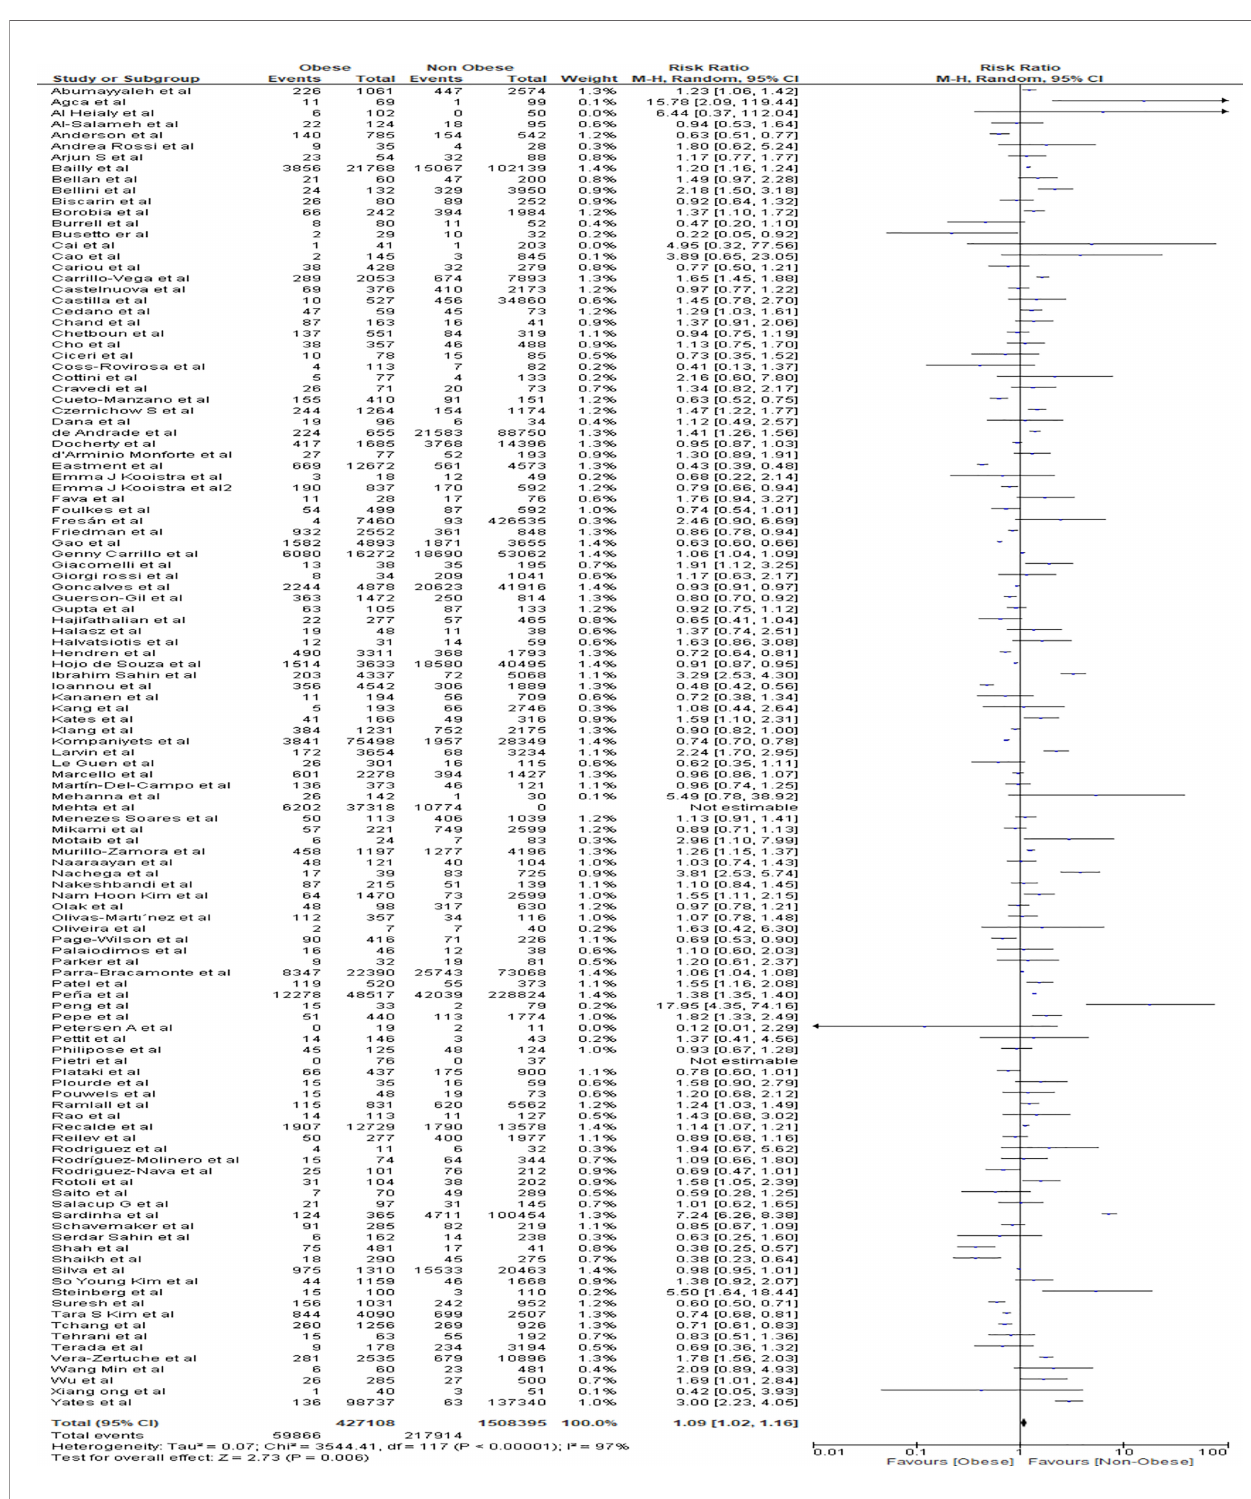
FIGURE 3 | Forest plot for mortality